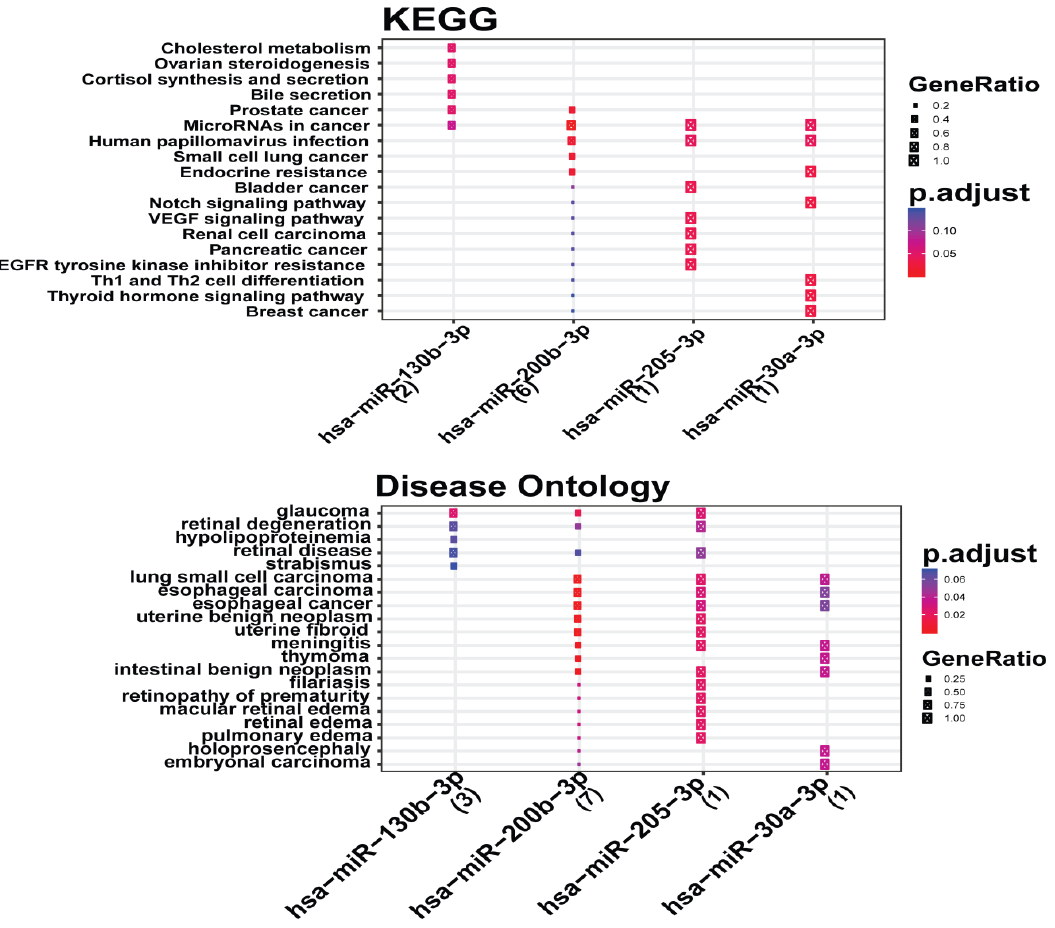
Figure 8. MiRNA enrichment analysis. (Upper Panel) Mieunturnet used to explore the KEGG pathways of miRNAs. (Lower Panel) Disease ontology of miRNAs. Abbreviations: KEGG: Kyoto Encyclopedia of Genes and Genomes.